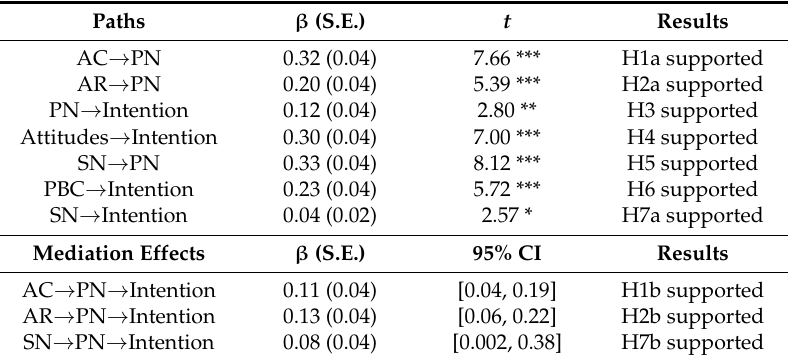
Table 4. Hypothesis Test